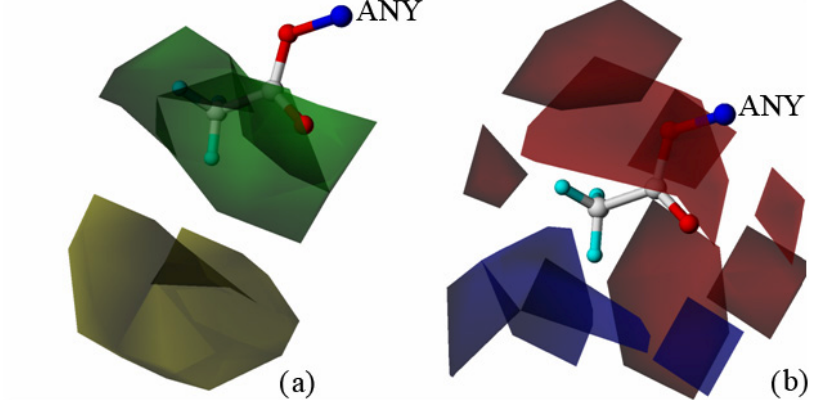
Figure 5. Contour maps of topomer CoMFA around R2. ( a ) Steric contour map depicted around R2 (green favored; yellow disfavored); ( b ) electrostatic contour maps depicted around R2. Blue contours indicate the regions where electropositive groups increase activity, and red contours indicate the regions where electronegative groups increase